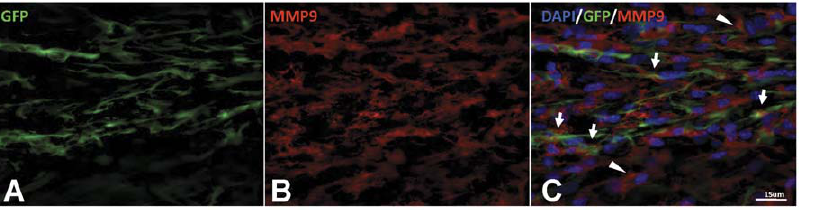
Figure 4. Invivo expression of MMP9 by transplanted NSC cells. Confocal image of engraftment shows NSCs (arrows) and host cells (arrowheads) were immunoreactive for MMP9 (A–C). The images shown are representative of an analysis of three sections (each) from three animals. 1 m m z-plane depth in A–C.